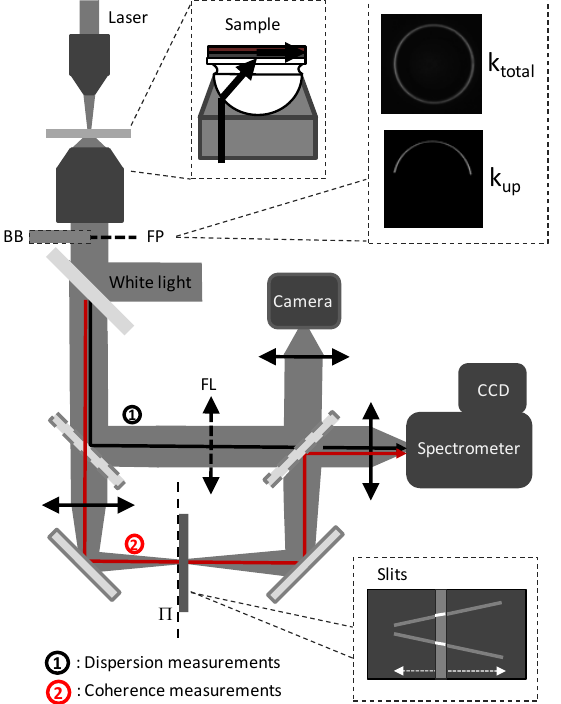
Figure 5. Sketch of the leakage radiation microscopy setup. BB denotes the position of the removable beam block, FP the Fourier plane, FL the Fourier lens, and Π the intermediate image plane of the sample surface in which are inserted the Young’s slits. The black line labeled 1 is devoted to dispersion measurements, and the red line labeled 2 to coherence